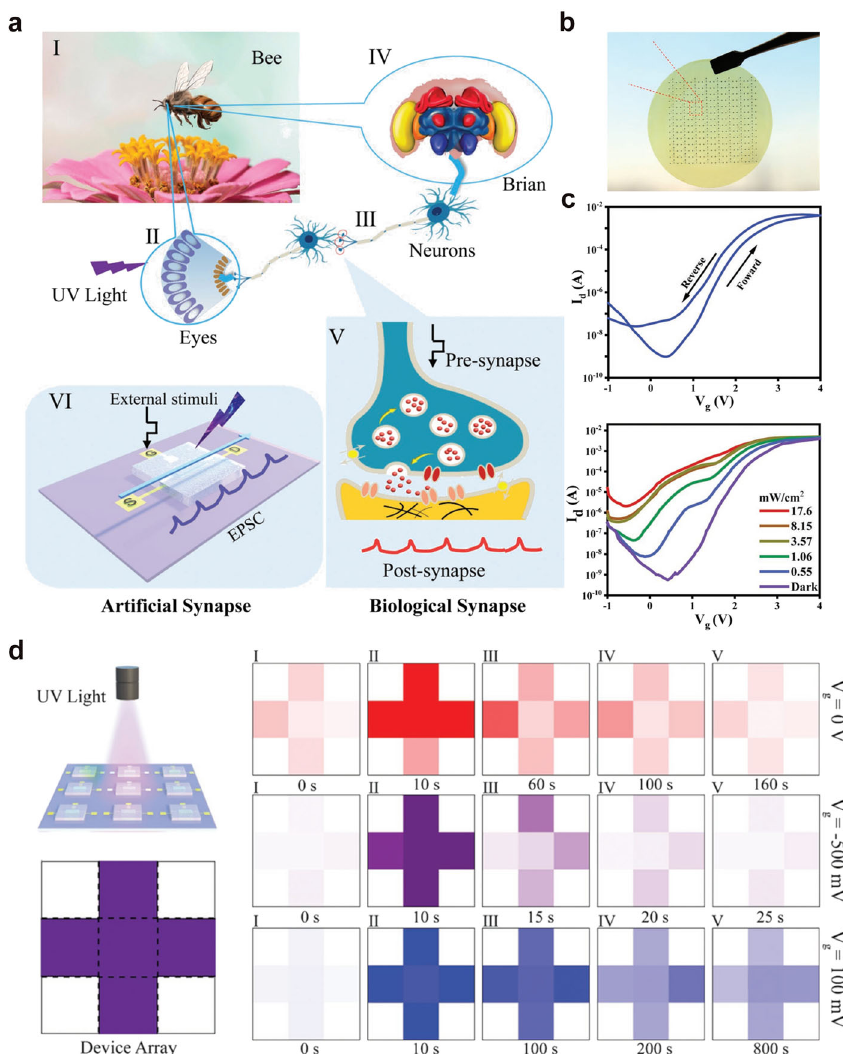
Fig. 9 The scheme and functions of a visual synapse. a Schematic diagram of device structure and bionic function. Reproduced with permission 118 . Copyright 2020, Wiley-VCH. b Optical photo of ZnO/SA-based SFET. c Electrical characteristics of the bioinspired fl exible ZnO/ SA-based SFET. d Arti fi cial visual memory systems based on